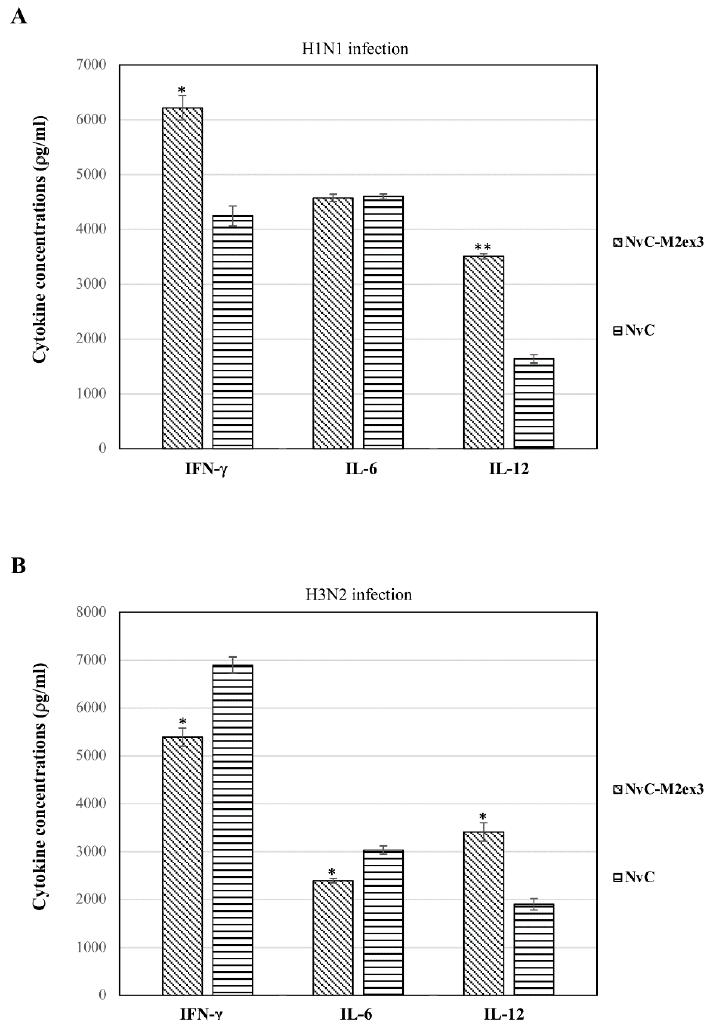
Figure 4. Concentration of cytokines in the lungs of mice (n = 3) infected by H1N1 and H3N2. The mice vaccinated with NvC-M2ex3 demonstrated di ff erent cytokine profiles after being challenged with H1N1 and H3N2. ( A ) A higher level of IFN- γ and IL-12 was detected in the lungs of the mice immunized with NvC-M2ex3 compared to the control group after being challenged with H1N1. ( B ) On the contrary, when the mice were challenged with H3N2, they exhibited lower concentrations of IFN- γ and IL-6, although a higher level of IL-12 was observed. The asterisks (* p < 0.05, ** p < 0.01,) indicate statistical significance of the results between di ff erent treatment